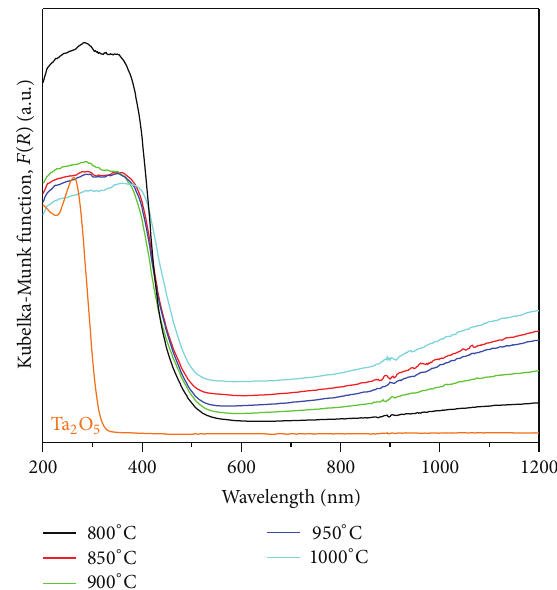
Figure 5: UV-visible diffuse reflectance spectra of the 𝛽 -TaON